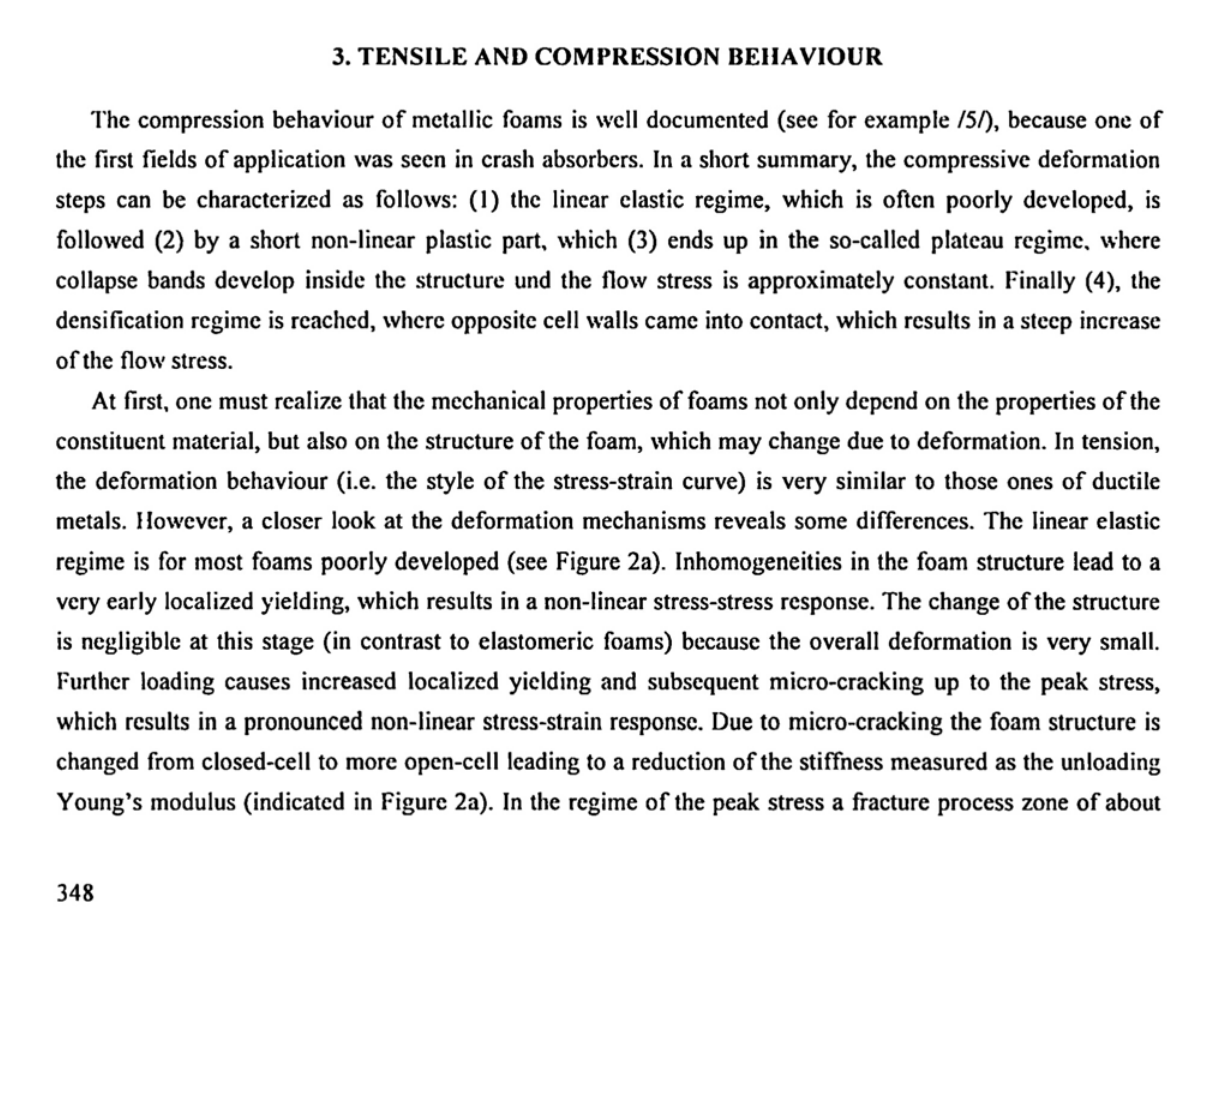
Fig. 1: Cellular structure of the investigated ALPORAS® aluminium